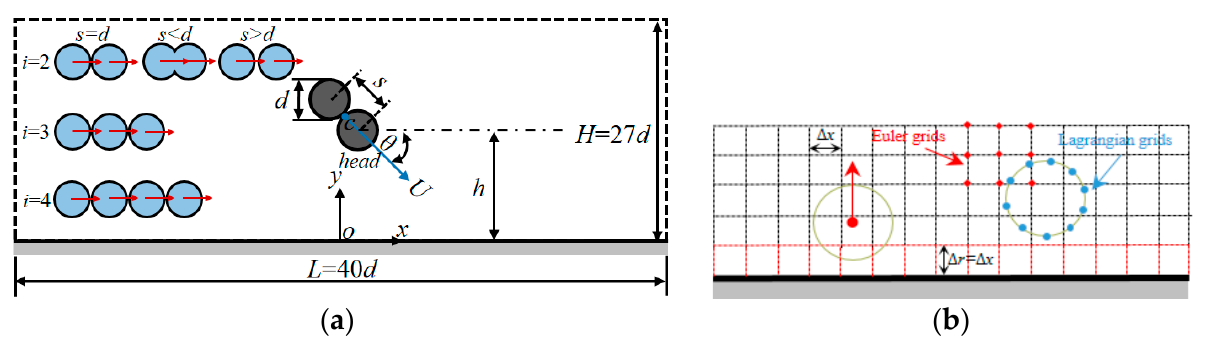
Figure 1. Schematic diagram of the flow. ( a ) Rod-shaped squirmer near the wall; ( b ) lattice. The rod-shaped squirmer is assumed to be rigid, and its motion is governed by Newton’s second